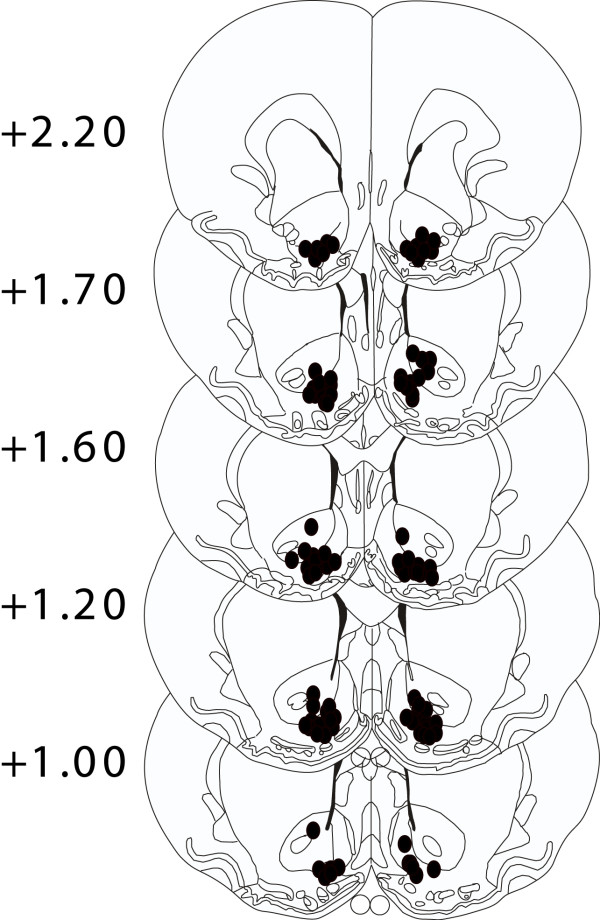
Drawings of coronal sections through the nucleus accumbens indicating sites of infusion. Injections of EGLU (0.0, 0.001, 0.01, 0.4 or 0.8 μg/0.5 μl/side) were followed by amphetamine injections (20 μg/0.5 μl/side) before conditioning sessions or 0.01 μg EGLU alone before conditioning sessions. Injector sites may appear fewer than the reported number of rats because of overlap of placements. Numbers to the left indicate distance (in millimeters) from bregma.